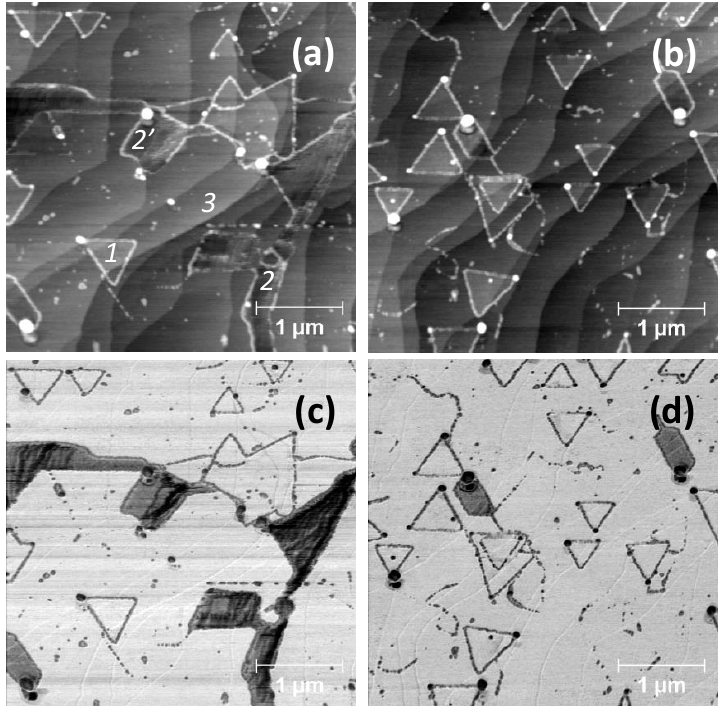
Figure 3. UFM data obtained on two different areas of a sample grown and aged in the same conditions of the samples in Figures 1 and 2: ( a , b ) morphology and ( c , d ) the corresponding elastic channels. Height values: triangular terraces, 0.5 ± 0.2 nm (point 1); crystal edges, from 2 to 4 nm; bumps, from 10 to 30 nm.